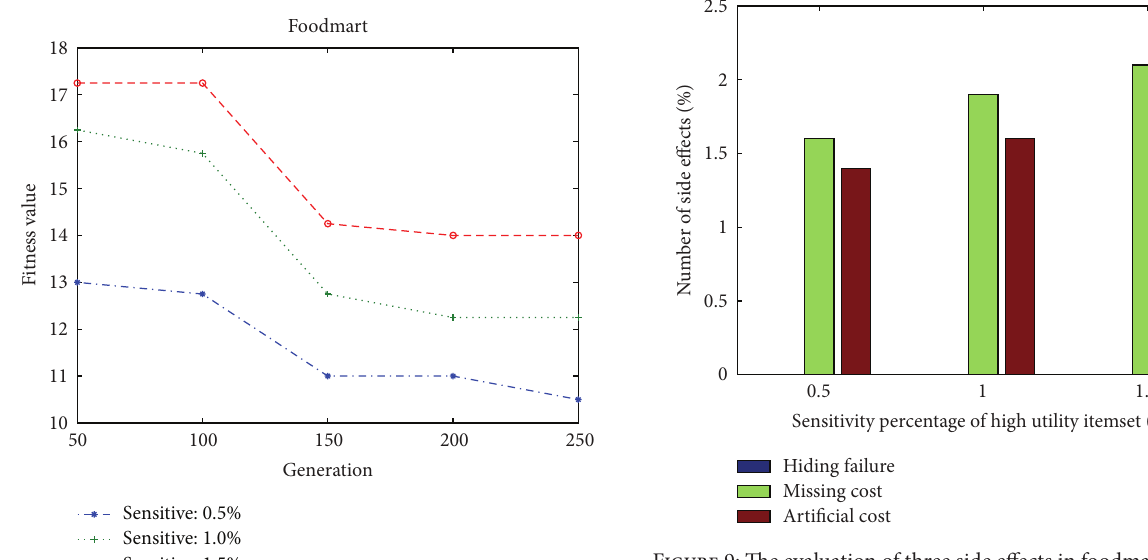
Figure 9: The evaluation of three side effects in foodmart